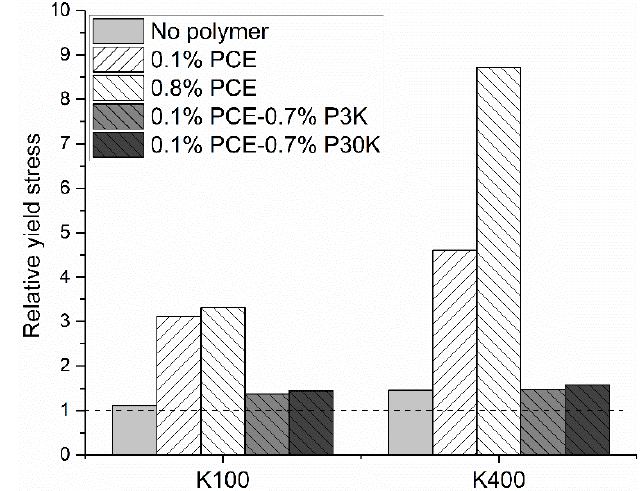
Figure 9. Relative yield stress of GBS, with the addition of different polymers with increasing [K + ].